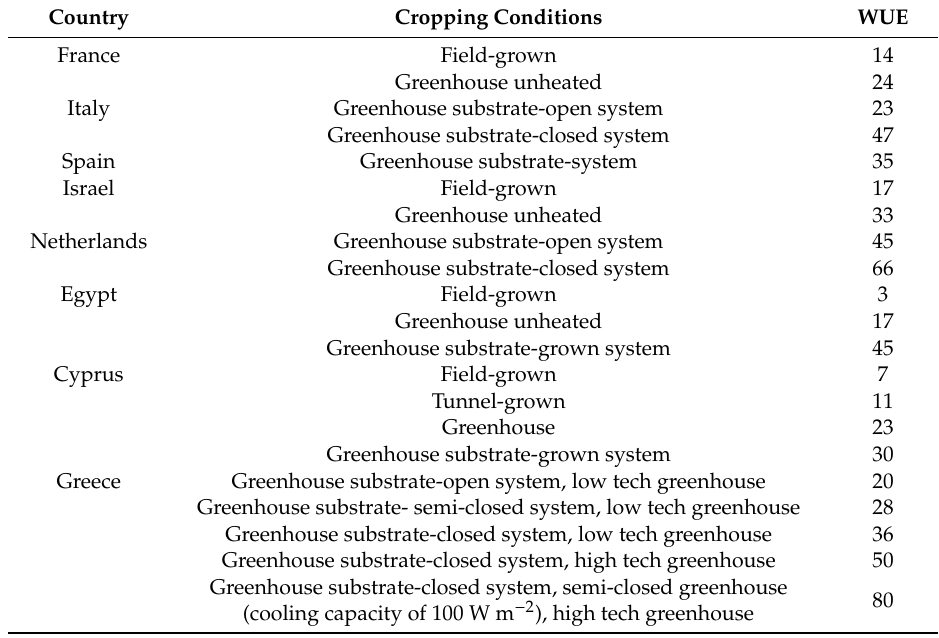
Table 4. Tomatoes water use e ffi ciency values (WUE; Kg m − 3 ) in di ff erent growing conditions and substrate. Data adapted from